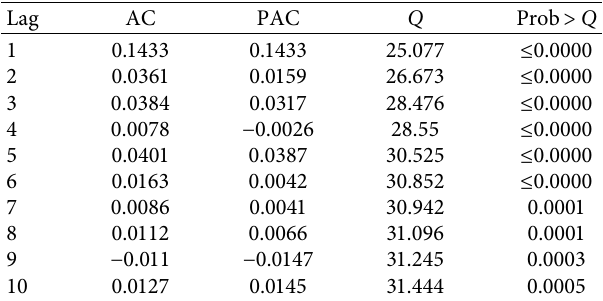
Table 2: The autocorrelation and partial autocorrelation tests on the yield data of China’s soybean futures